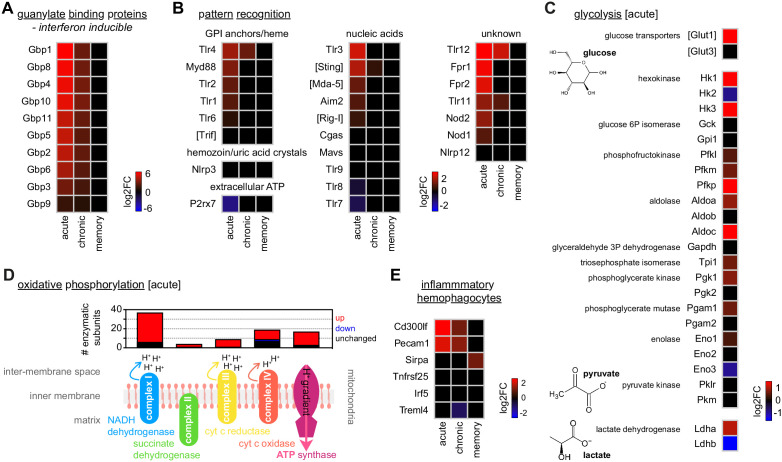
Monocytes upregulate glycolysis and oxidative phosphorylation as they differentiate into inflammatory macrophages.(A and B) RNA sequencing of spleen monocytes flow-sorted from AJ-infected mice (7 and 40 days p.i.for acute and chronic, respectively) and once-infected mice (memory, 70 days p.i.). Shown is the log2 fold change (FC) of (A) interferon-inducible guanylate binding proteins and (B) pattern recognition receptors (PRR). At each time point, log2FC is shown relative to uninfected controls. If parasite- or host-derived ligands have been identified for PRR in malaria these ligands are labelled. (C) Log2FC of the major glucose transporters and glycolytic enzymes in spleen monocytes flow-sorted from AJ-infected mice (acute, 7 days p.i.) – data are shown relative to uninfected controls. Note that under anaerobic conditions pyruvate can be further converted to lactate by lactate dehydrogenase, which is also shown. (D) Transcriptional regulation of oxidative phosphorylation in spleen monocytes flow-sorted from AJ-infected mice (acute, 7 days p.i.). Data show the number of enzymatic subunits that are transcriptionally up- or downregulated compared to uninfected controls (padj <0.01, >1.5-fold change) – all subunits that are required to form complex I to IV in the electron transport chain and ATP synthase are shown. (E) Log2FC of signature genes used to predict monocyte differentiation into inflammatory hemophagocytes; data are shown relative to uninfected controls. At each time point in (A–E), n = 5–6 for infected mice and n = 6–7 for uninfected controls. Square brackets indicate that common gene names were used.